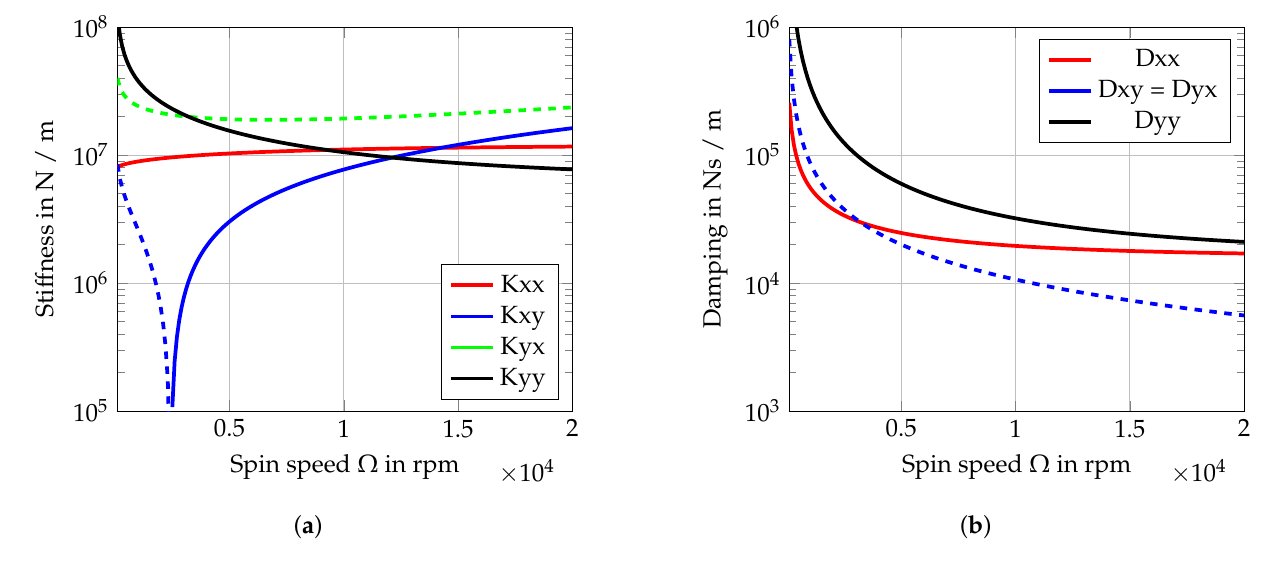
Figure 4. ( a ) Speed dependent stiffness and ( b ) speed dependent damping. The NAT simulation was compared with an FEM model built using the Friswell code, where the shaft was modeled with 100 elements á 0.01 m. Due to the discretization, FEM simulations with few elements tend to calculate higher natural frequencies than analytic calculations. This effect is reduced and nearly eliminated with increasing element count [29]. Therefore, the critical speeds calculated with the FEM model were slightly higher than those found by the quasi-analytical NAT simulation. As is seen in the Campbell diagram (Figure 5) and Table 2, the differences between the calculations were negligible.